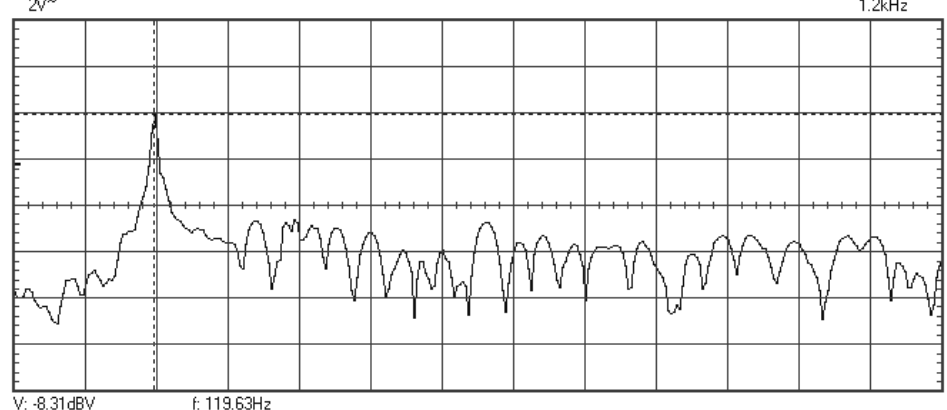
Figure 9. Amplitude spectrum for additional mass of 0.620 kg, recorded at the initial moment.